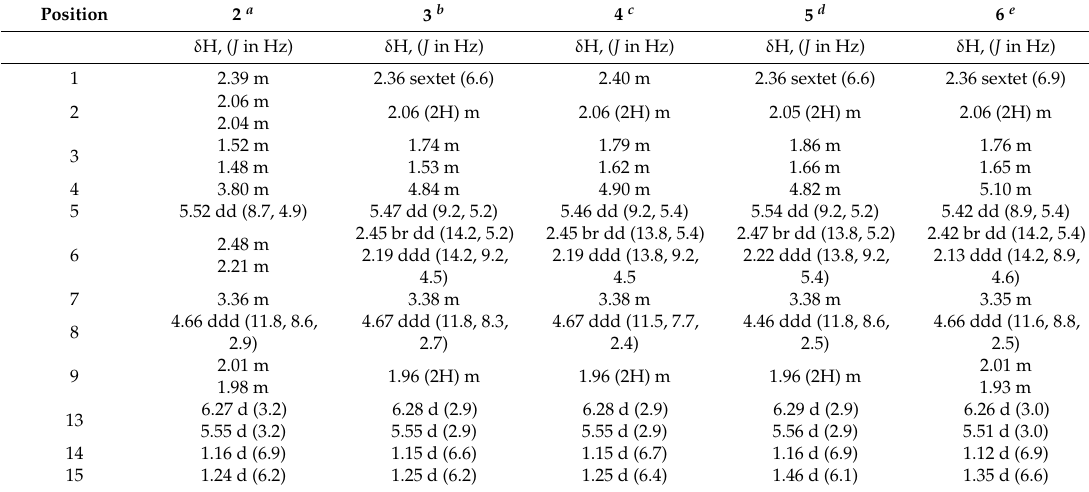
Table 2. 1 H-NMR data of inuloxin D ( 2 ) and its derivatives ( 3 – 6 ).